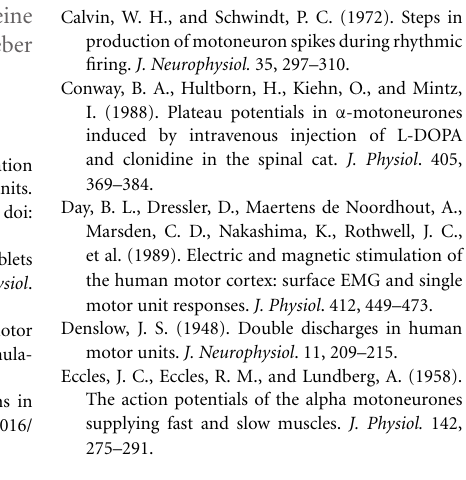
Bottom, an MU displaying both single-spike firing and doublet firing; gray bars: single-spike ISIs ( n = 1 , 193), black filled bars: intradoublet ISIs ( n = 234), black open bars: interdoublet ISIs ( n = 234). Bin width for intradoublet ISIs, 1ms; for the rest, 5ms. (D) MU intradoublet ISIs in various muscles; black bars: single and repetitive doublets in the trapezius, triceps brachii, and latissimus dorsi ( n = 8 , 807); gray bars: single doublets in the flexor carpi ulnaris, first dorsal interosseous, and tibialis anterior ( n = 107). Bin width,